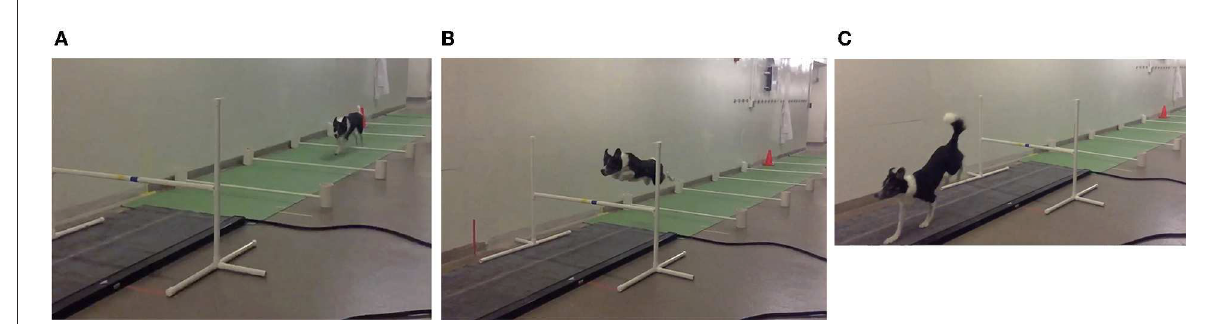
FIGURE1 Images of bar jump and PSW set-up. An AKC regulation bar jump (see footnote 1) was placed centrally over a pressure sensitive walkway (PSW) (see footnote 2). Five ground poles spaced 50 inches apart were placed along the runway in front of the bar jump that were three inches above the ground. During the run, the dog jumps between each of the ground poles (A) , before taking off between the last ground pole and the regulation bar jump (B) , and landing on the PSW (C) .